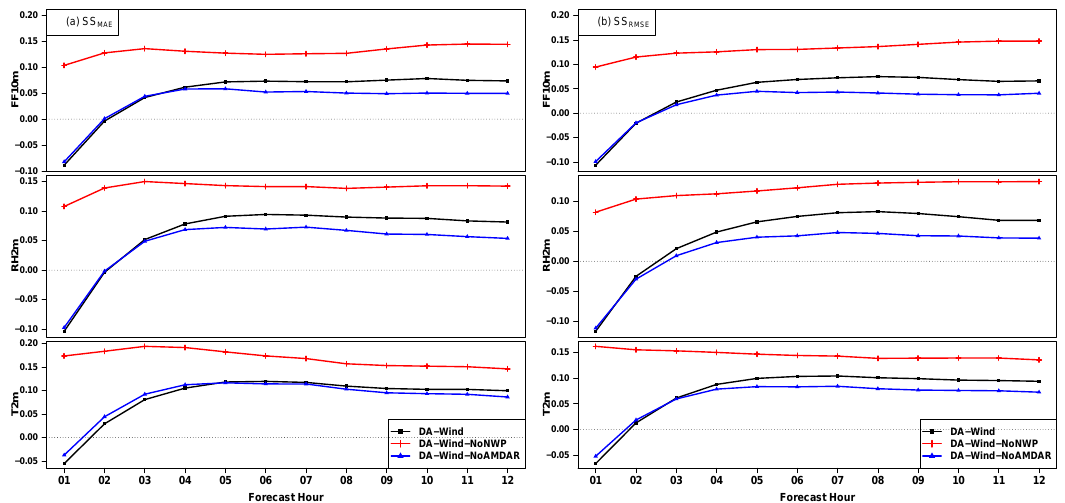
Figure 6. Evolution of skill scores of : ( a ) MAE (left) and ( b ) RMSE (right), as function of forecast hours, for near-surface (at 2 m) temperature and relative humidity, and 10 m wind